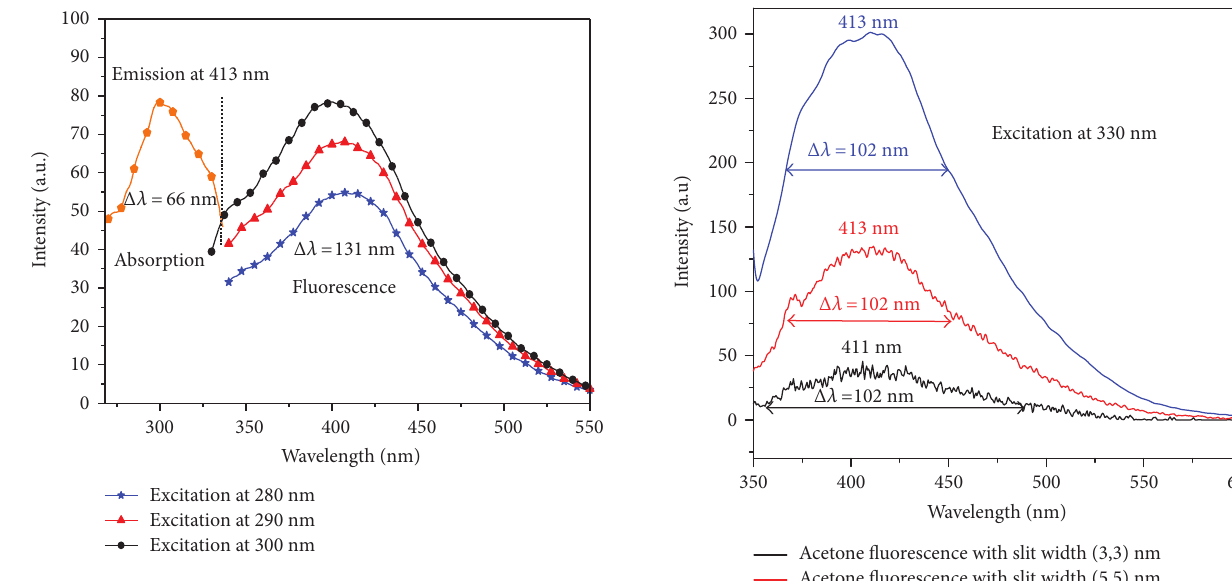
Figure 2: The fl uorescence spectra of acetone with a peak at 413nm for di ff erent wavelengths of excitation; on its left side is the excitation spectra with a peak at 327nm. Figure 3: Acetone fl uorescence with di ff erent slit widths.